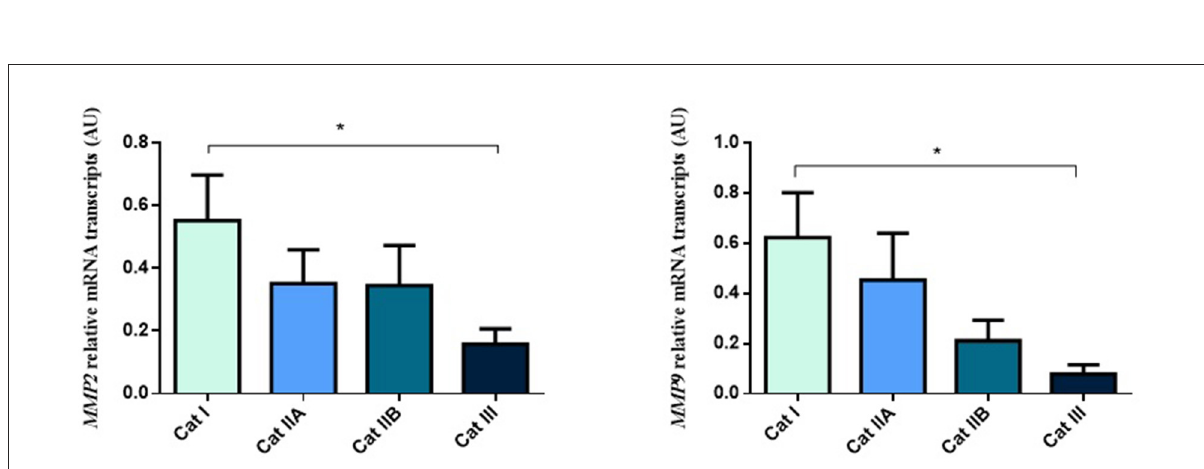
FIGURE2 Relative MMP2 and MMP9 transcripts in equine endometrium graded as Kenney and Doig’s categories I, IIA, IIB and III. Bars represent mean ± SEM. The asterisk indicates significant differences between endometrial categories (* P < 0.05).